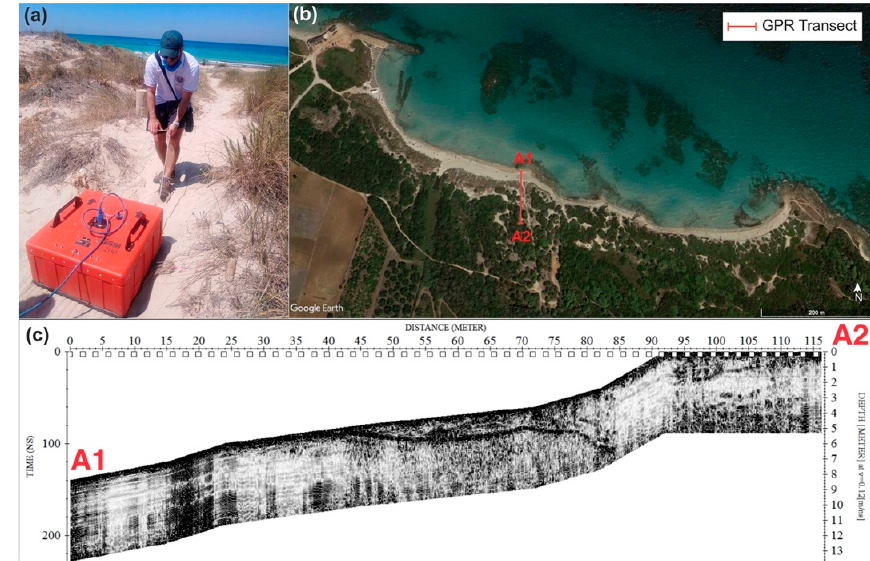
Figure 10. GPR procedure example. ( a ) 200 MHz antenna during a GPR field survey; ( b ) map showing the location of the measurement transect; ( c ) example of a radar stratigraphy section deriving from the measurement path A1–A2 by the use of 400 MHz antenna.